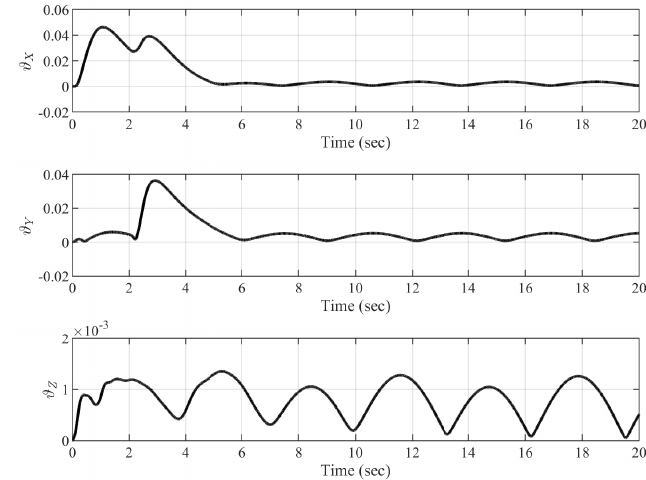
Figure 14. The estimation of adaptive parameters ϑ X , ϑ Y , ϑ Z